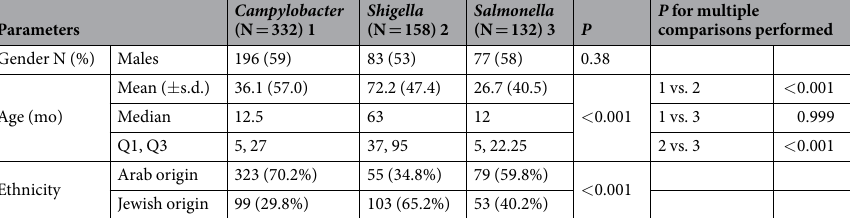
Table 1. Demographic characteristics of children with Campylobacter , Shigella and Salmonella in north-eastern Israel,